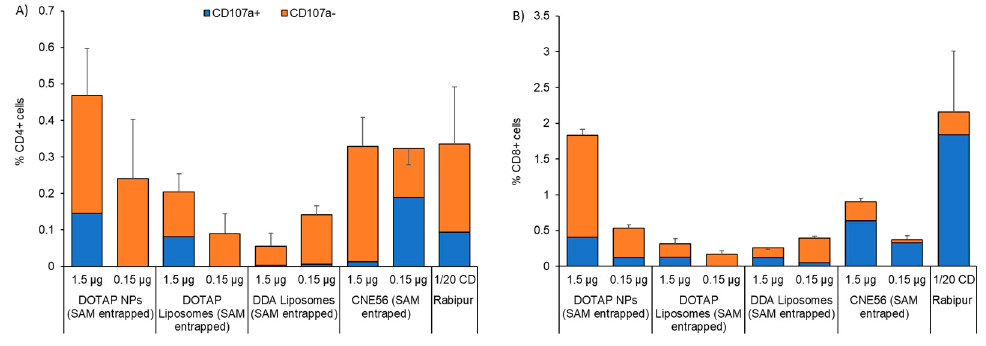
Figure 6. Percentages of cytotoxic CD4 + or CD8 + T-cells. The induction of rabies-specific CD4 + or CD8 + T-cells by either 1.5 or 0.15 µ g / dose of SAM encapsulating nanoparticles (NPs), DOTAP liposomes and DDA liposomes was characterized 2 weeks after the second immunization. Spleens from 3 mice were randomly selected from each group. Candidates were compared with the commercial vaccine Rabipur (1 / 20 of human dose) and GSK trademark CNE56 as positive controls. Surface expression of CD107a on splenocytes stimulated in vitro with rabies G1 / G2 / G3 peptide was assessed by flow cytometry. Data show the frequency of cytokine-secreting ( A ) CD4 + or ( B ) CD8 + T-cells that express (blue bars) or do not express (orange bars) CD107a. Unstimulated cells were used as control. Refer to Figure S3 in the Supplemental Material for the gating strategy.